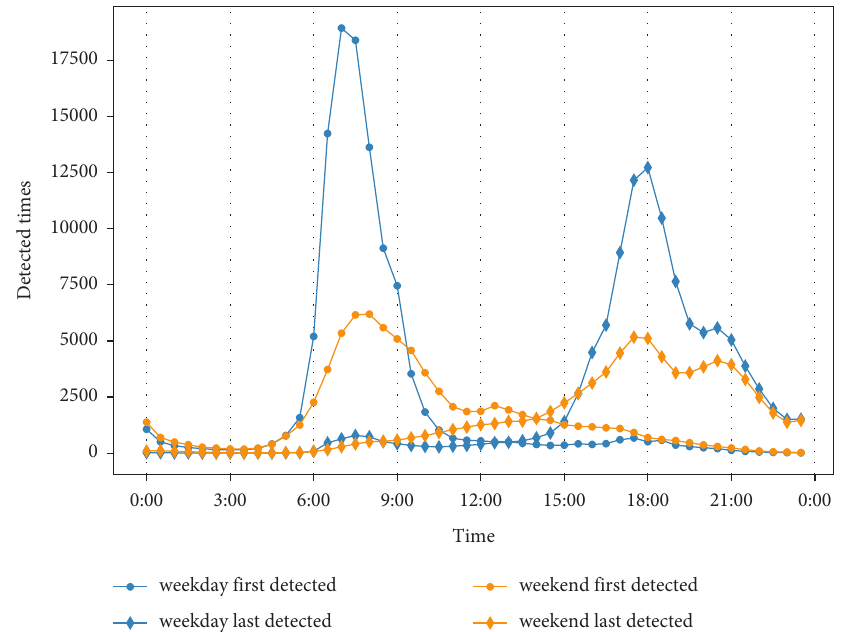
Figure 2: The average first and last detected time distributions of commuting pattern vehicles on weekdays and weekends.